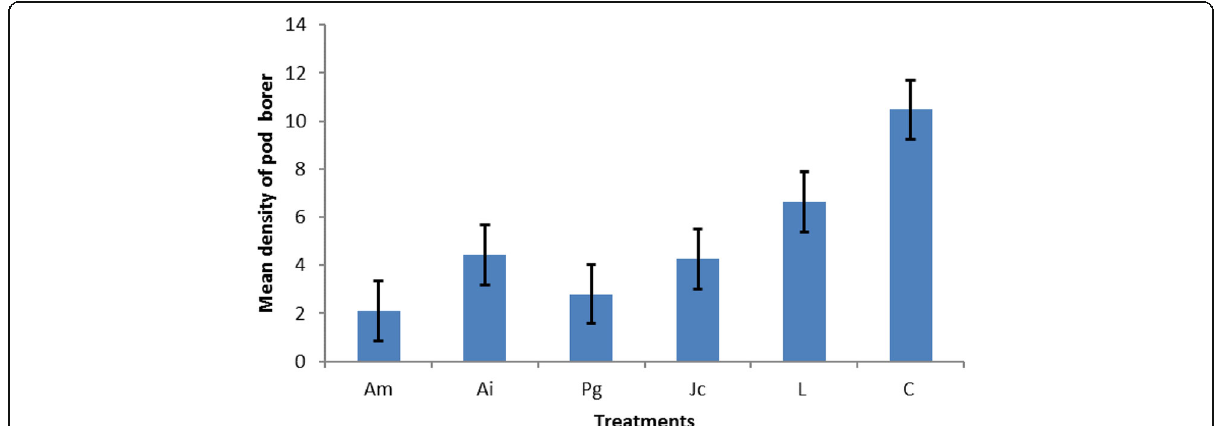
Fig. 2 Effect of treatments on the population of legume pod borer on cowpea. Mean values are the number of legume pod borer larvae observed in 20 flowers sampled per plot per week during the flowering period of the cowpea from different plots treated with different botanicals. Am, plot treated with Annona muricata ; Ai, plot treated with Azadirachta indica ; Pg, plot treated with Piper guineense ; Jc, plot treated with Jatropha curcas ; L, lambdacyhalothrin; C, control (no